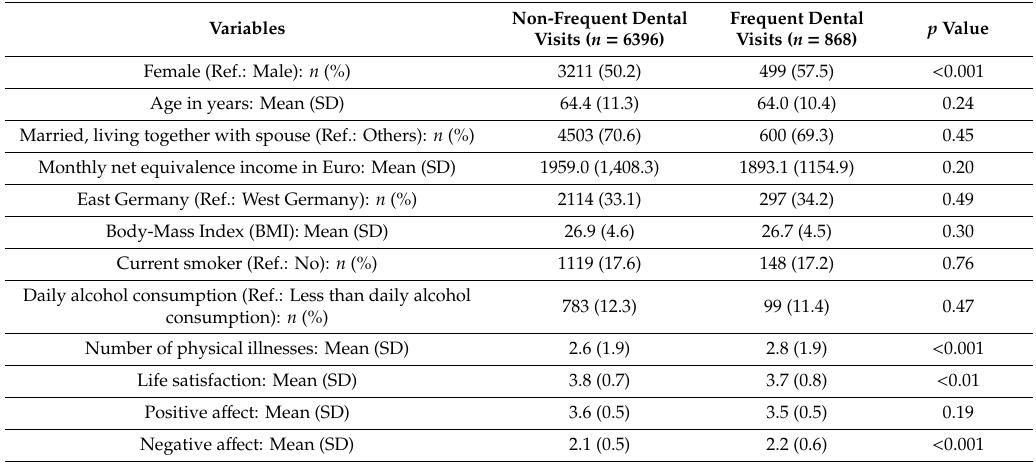
Table 1. Sample characteristics, by status (non-frequent dental visits; frequent dental visits ( n = 7264). Variables